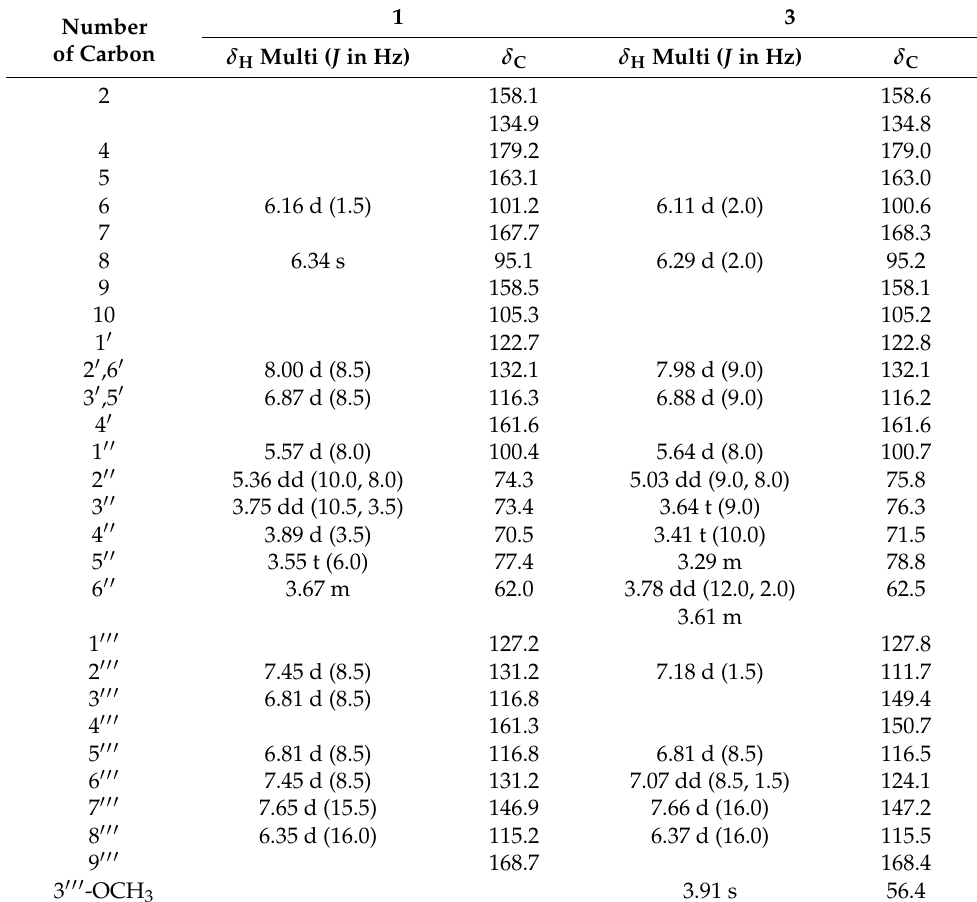
Table 1. 1 H and 13 C NMR data of compounds 1 and 3 in methanol- d